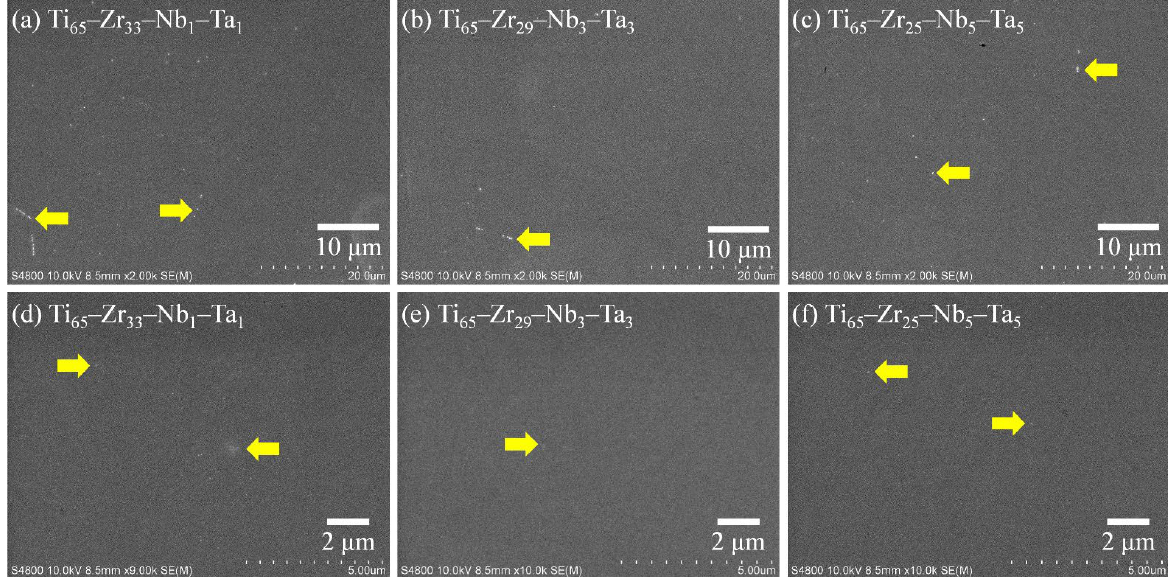
Figure 11. Scanning electron microscopy images of Ti 65 –Zr 33 –Nb 1 –Ta 1 , Ti 65 –Zr 29 –Nb 3 –Ta 3 , and Ti 65 –